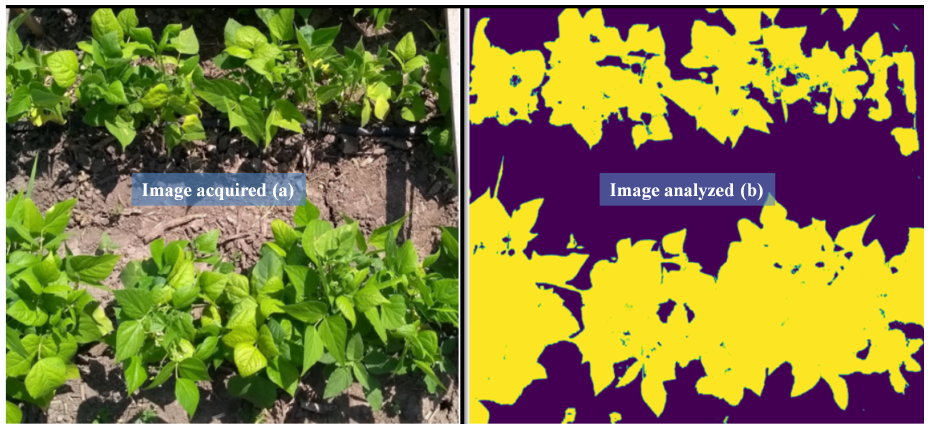
Figure 4. Canopy cover